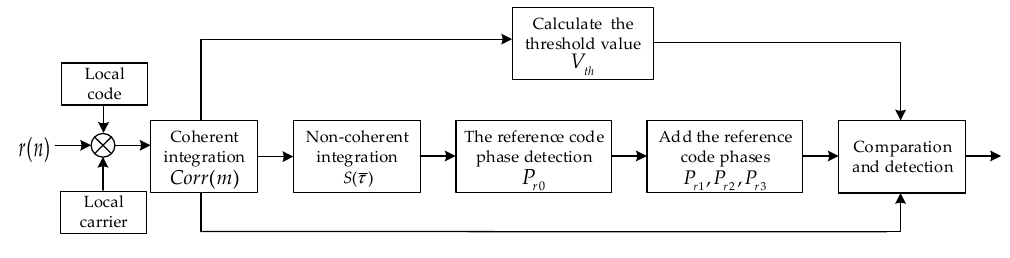
Figure 10. Flowchart of the MFADD.